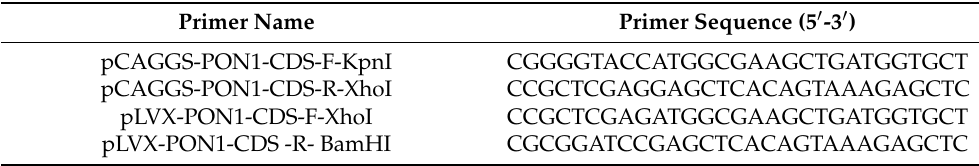
Table 2. Primers used for plasmid